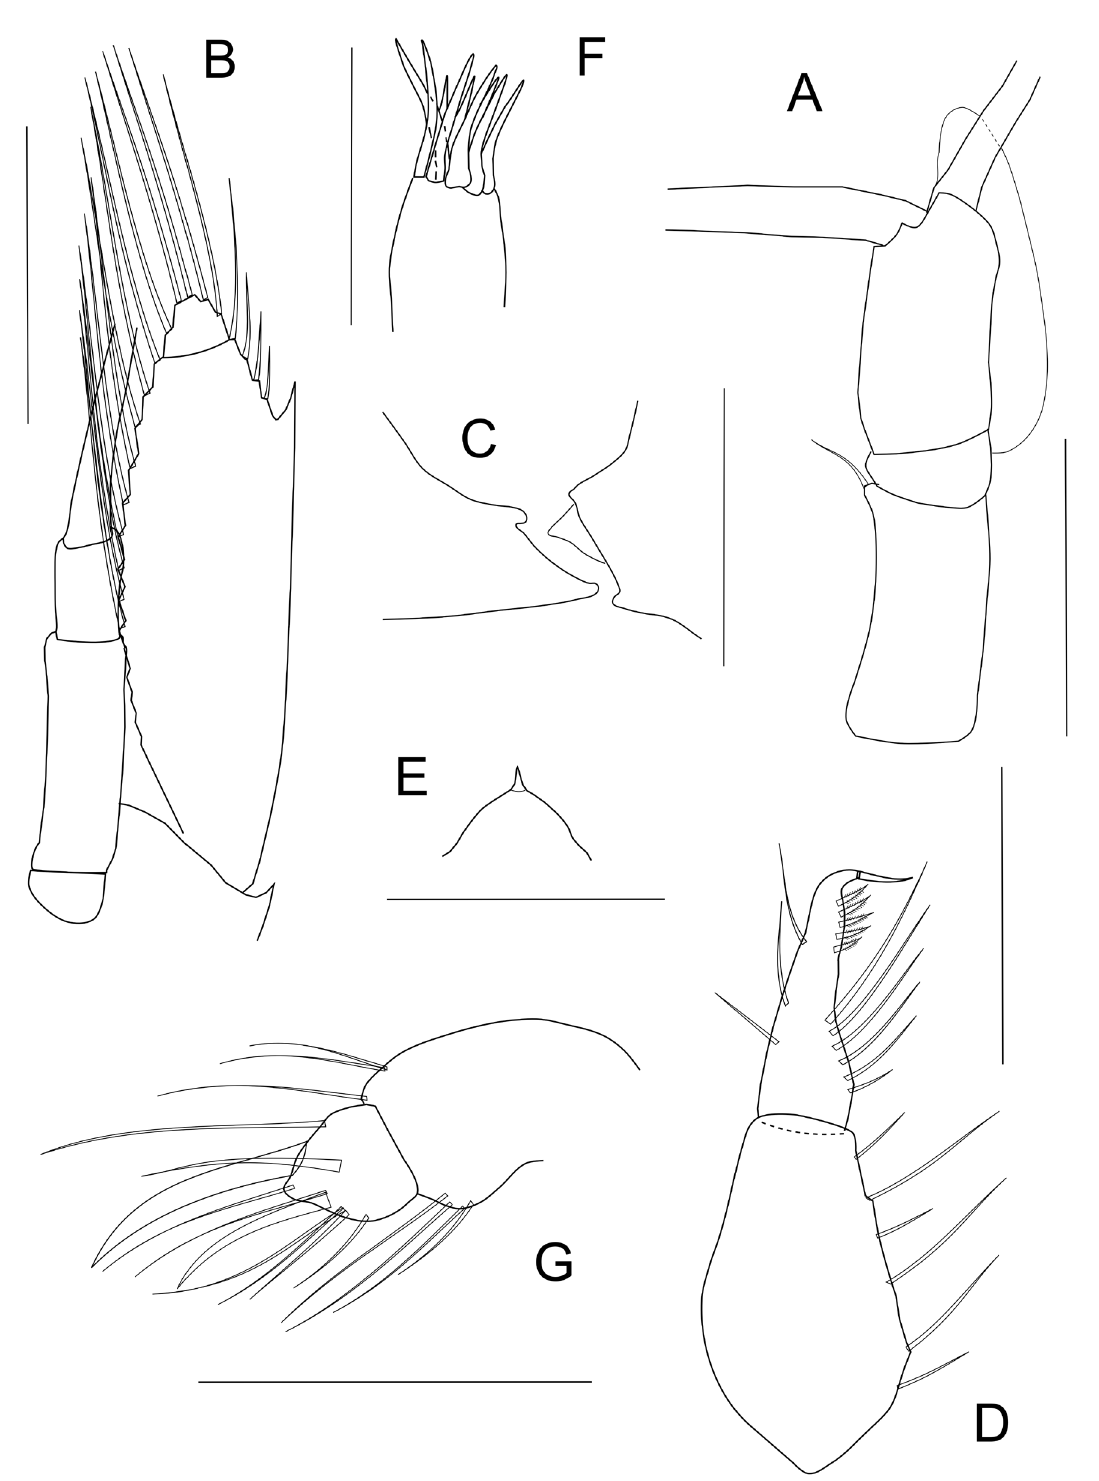
Fig. 15. Siriella muranoi sp. nov., holotype, ♂, length 5.5 mm, Port Essington, Arafura Sea, Northern Territory, Australia. A . Antenna 1 peduncle, dorsal view. B . Antenna 2 (peduncle and antennal scale), ventral view. C . Mandibles, left and right. D . Mandibular palp, lateral view. E . Labrum. F . Inner ramus of maxilla 1, posterior view. G . Distal part of maxilliped 1, posterior view. Scale bars: A–B, D = 0.25 mm; C, E–G = 0.2